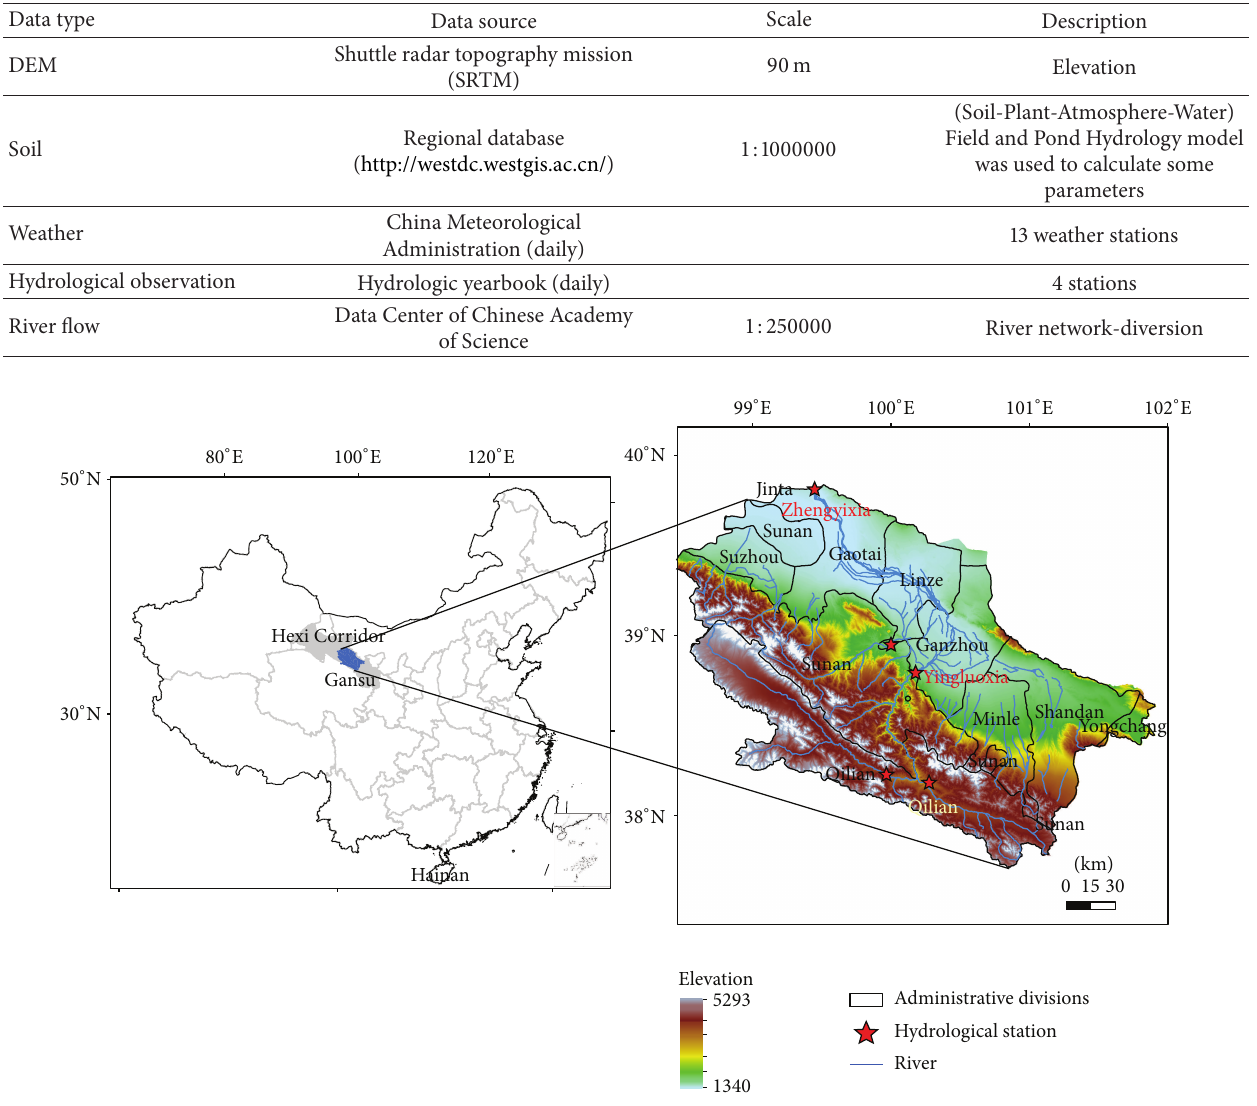
Figure 1: Location of administration region and hydrological station in the Heihe River